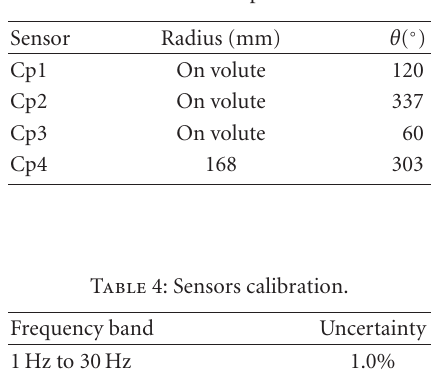
Table 3: Sensor positions.